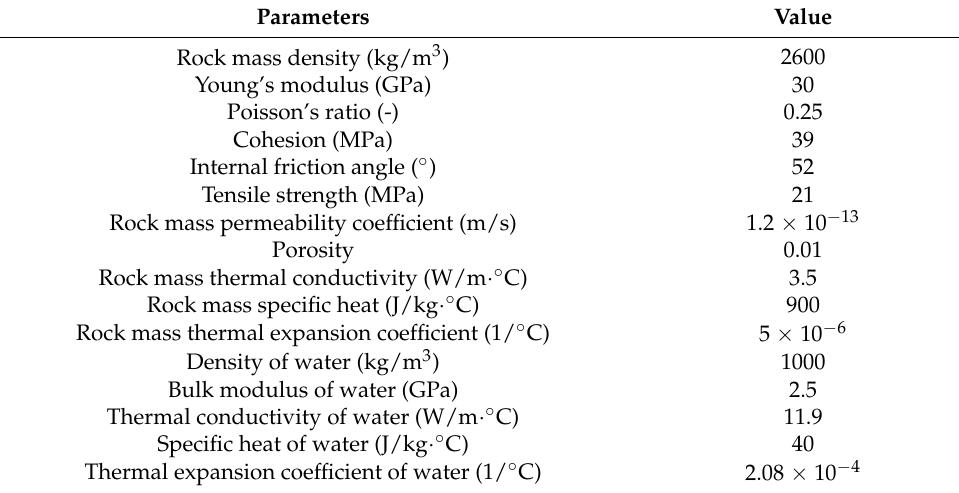
Table 2. The mechanical, thermal, and hydraulic properties of the